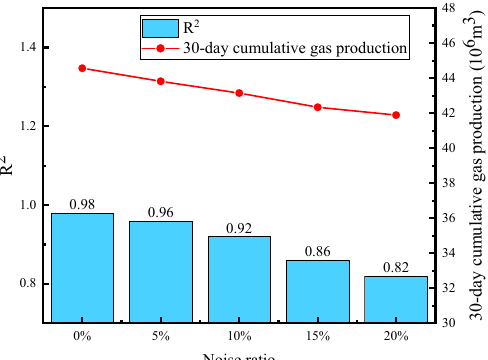
Figure 6. The results of robustness tests. The red points denote the optimization results of SGA in the different tests. The blue columns represent the R 2 of the XGBoost models in the five tests.